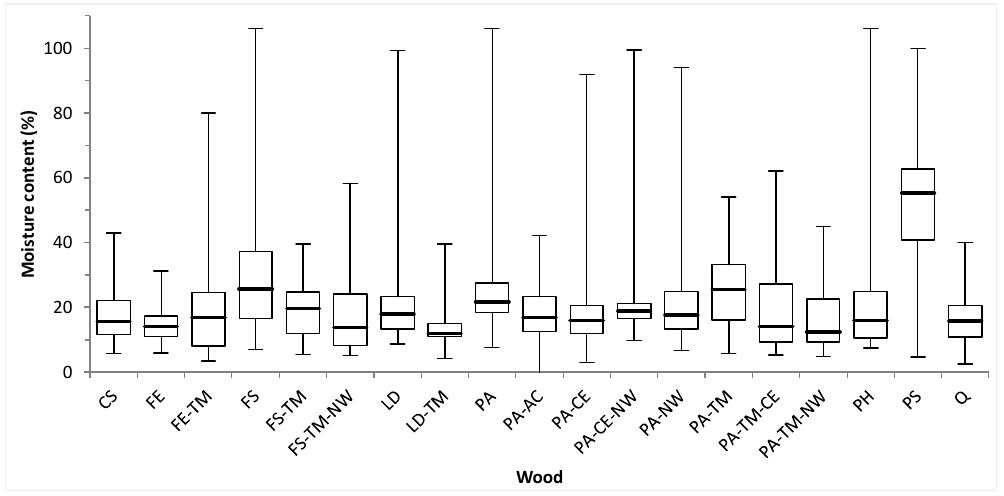
Figure 2. Distribution of moisture content in various wood-based materials exposed as decking of the model house in Ljubljana in the period between 11 April 2014 and 26 November 2018 ( n = 3381).